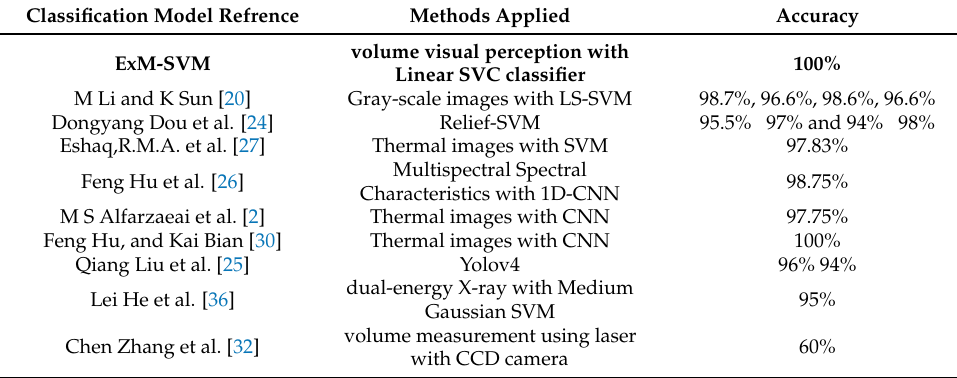
Table 7. ExM-SVM comparing to previous